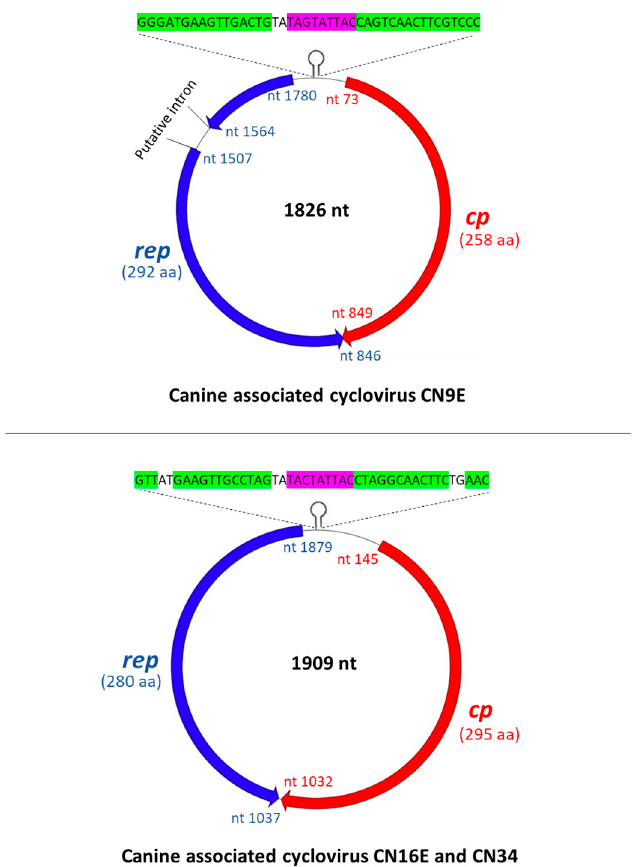
Figure 1. The organization of the complete genomes of canine associated cycloviruses CN9E, CN16E and CN34. The inversely arranged open reading frames coding for the putative replication-associated (Rep) and capsid (Cp) proteins are shown with blue and red arrows, respectively. The putative origin of replication (ori), marked by a nonanucleotide motif (highlighted with pink) at the apex of the stem–loop structure (complementary regions forming the ‘putative stem’ are shown with green), is shown in the 5 ′ -intergenic region. Following the recommendations of the International Committee on Taxonomy of Viruses [1,2], the first nucleotide (nt) of the nonanucleotide motif was recognized as nt ‘position one’ of the cyclovirus genomes. The sizes of Rep and Cp are mentioned in parentheses. nt: nucleotide; aa: amino acid.